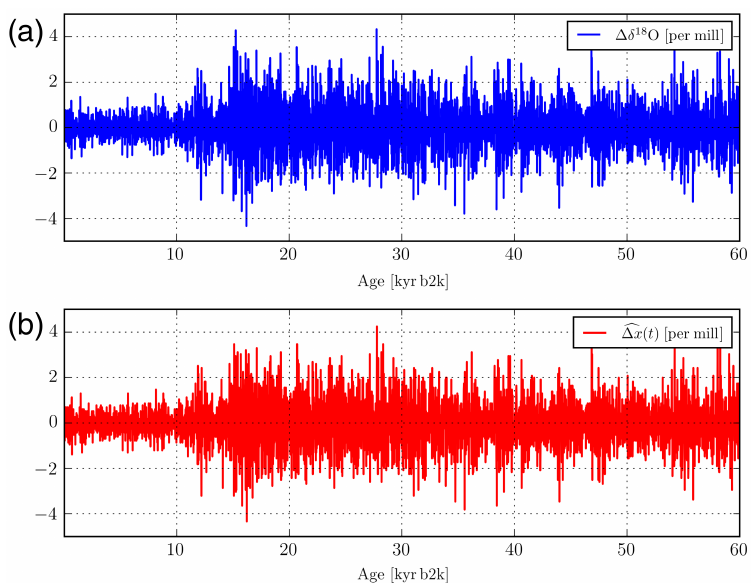
Figure 4. Representation of the one-step increments (cid:49)δ 18 O of the NGRIP record, taking into account the relative counting errors. (a) Tradi- tional representation of the increments (cid:49)δ 18 O between subsequent time steps; the time steps are obtained as in Fig. 3. (b) Representation of the δ 18 O increments between subsequent time steps as a sequence of probability densities, derived via Eq. (7). Note that the relative counting errors are sufficiently small to obtain very sharp, unimodal distributions p ( (cid:49)x | t,t + 1). For this reason, only the expectation value c (cid:49)x ( t ) (red line) of the increments with respect to p ( (cid:49)x | t,t + 1) is shown in this